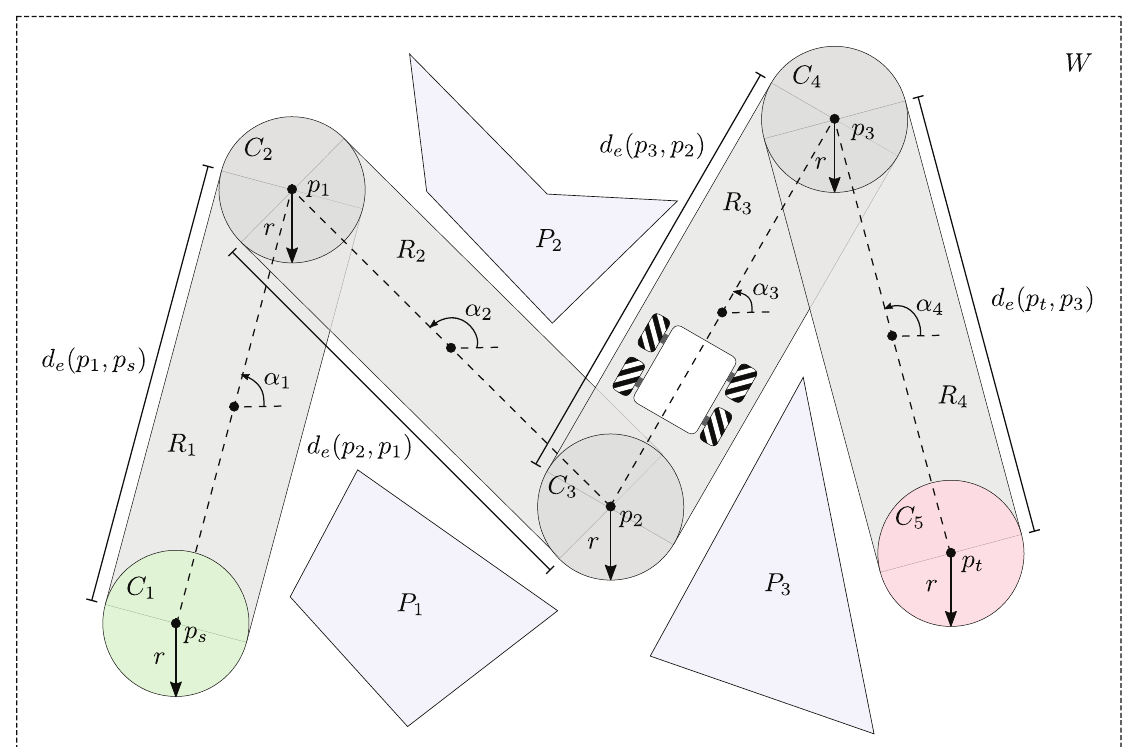
Figure 1. Example path computed for a workspace W with several